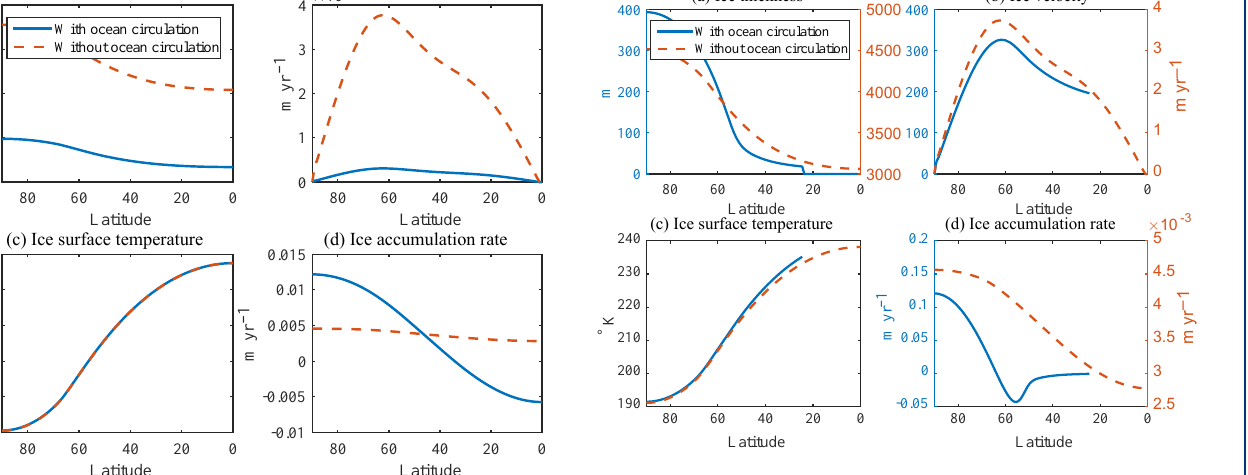
Figure 4. (a) Ice thickness h and (b) velocity v profiles with 94% insolation and ε = 0 . 82, with and without ocean circulation. We note neglecting oceanic heat transport leads to drastically different global climate states. (c) Ice surface temperature T s and (d) ice basal accumulation M , which without oceanic heat transport is positive